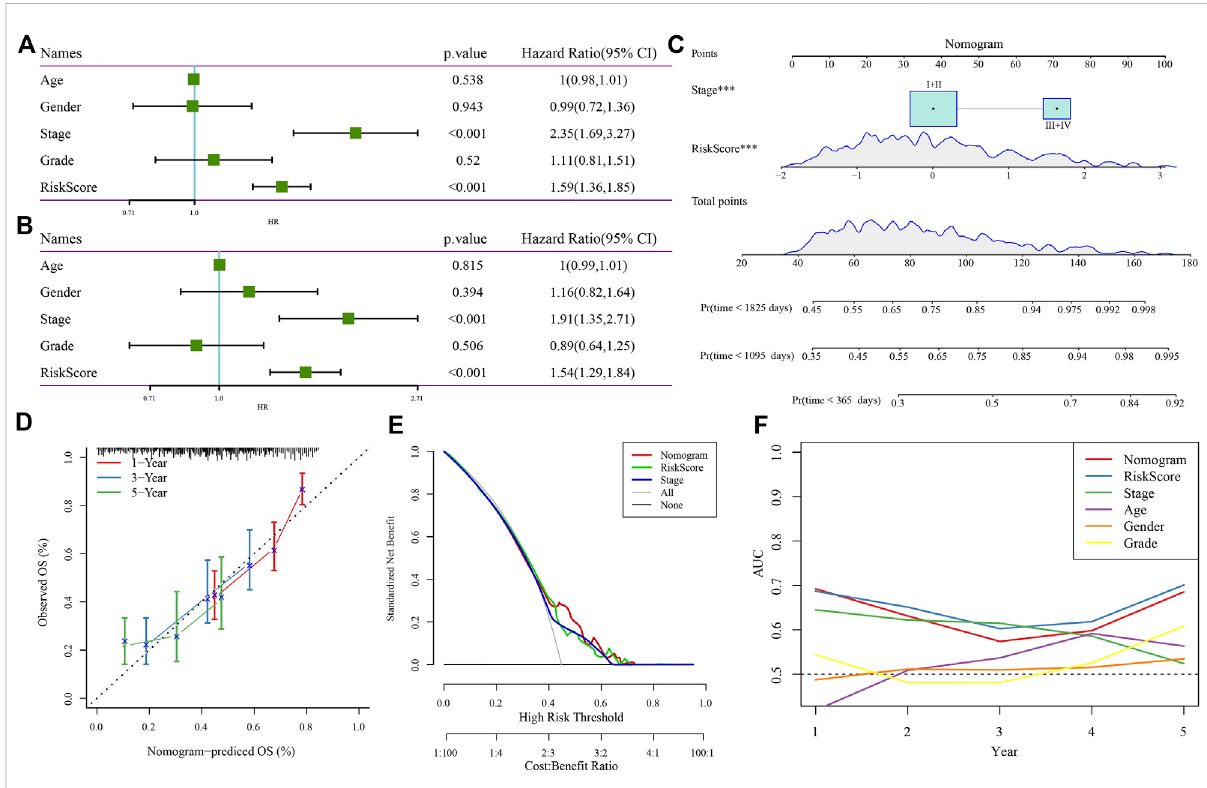
FIGURE 5 Nomogram construction and evaluation. Univariate (A) and multivariate (B) Cox regression analysis of the risk score, age, sex, stage, and grade. (C) Nomogram based on risk score and stage for predicting death rate at 1, 3, and 5 years. (D) Calibration curve for predicting the accuracy of the nomogram. (E) DCA plot of the nomogram, risk score, and stage. (F) AUC of the nomogram, risk score, and clinical